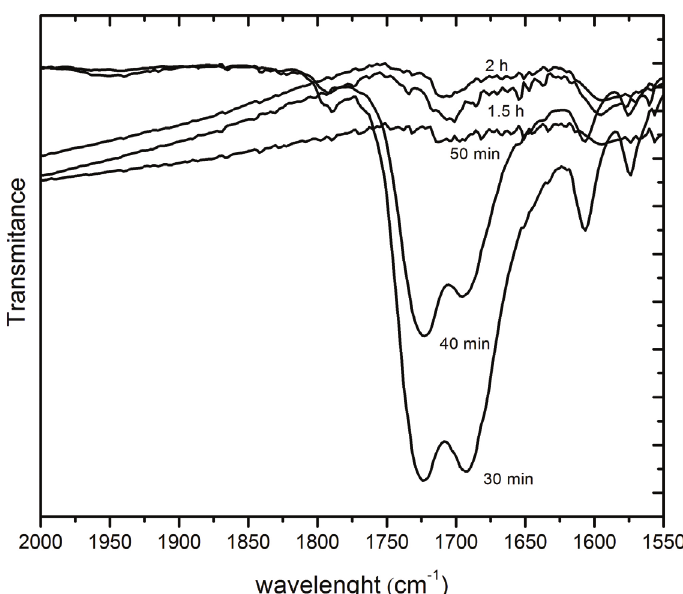
Figure 6. FTIR spectra obtained for different times in first